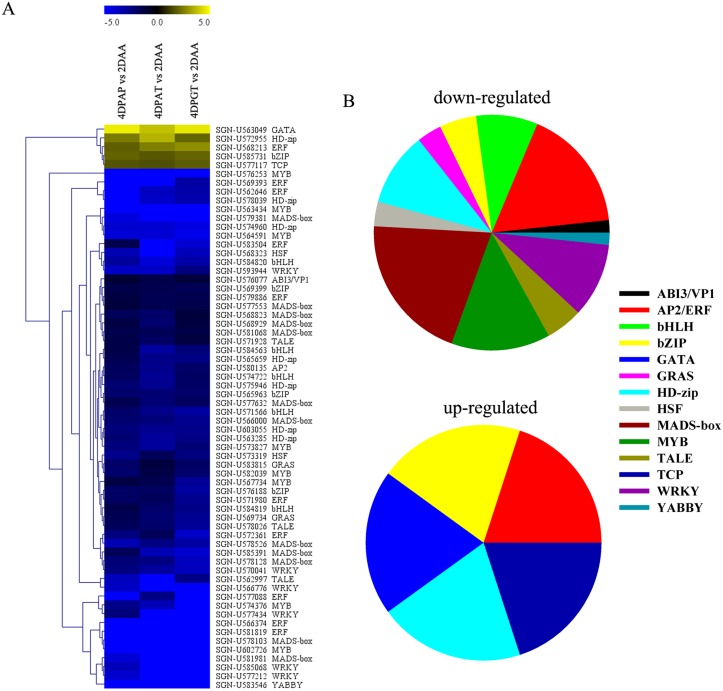
DEGs associated with transcription factors.(A) Cluster analysis of DEGs associated with transcription factors. (B) Pie charts show the up- and down-regulated TFs during fruit set.